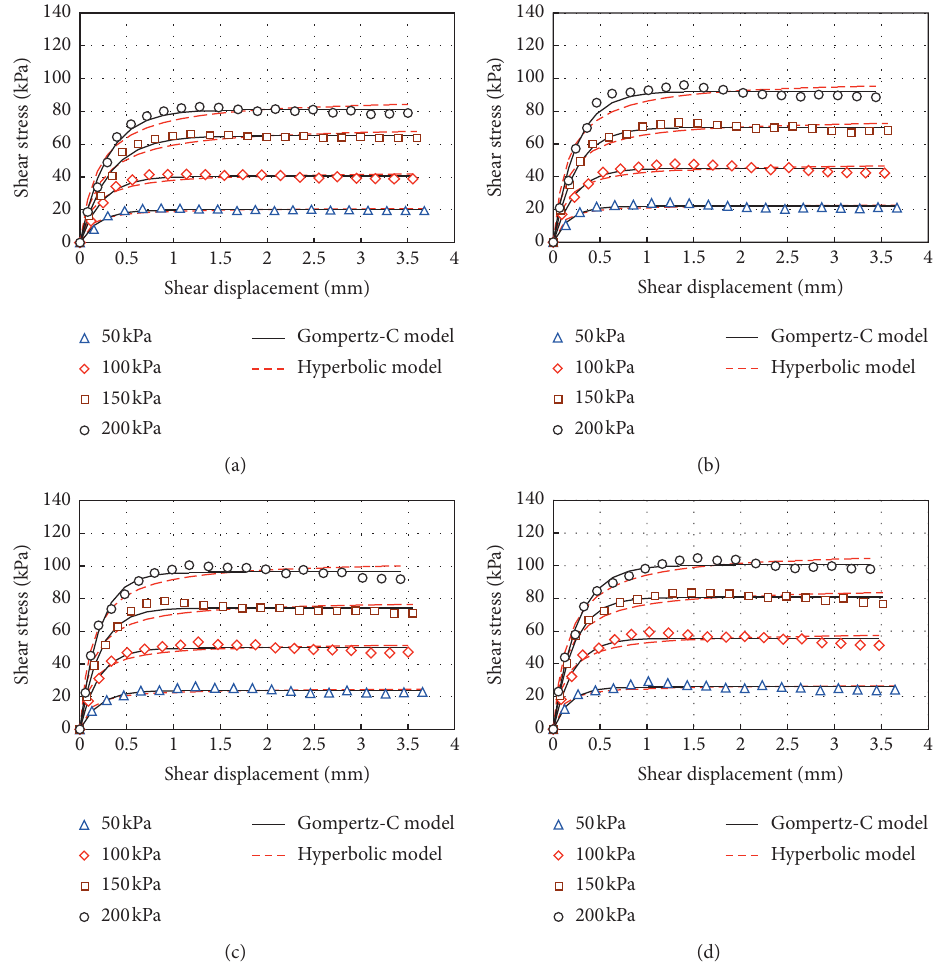
Figure 11: Model curves for sand-steel interfaces. (a) Int-A. (b) Int-D-0 ° . (c) Int-D-45 ° . (d) Int-D-90 °